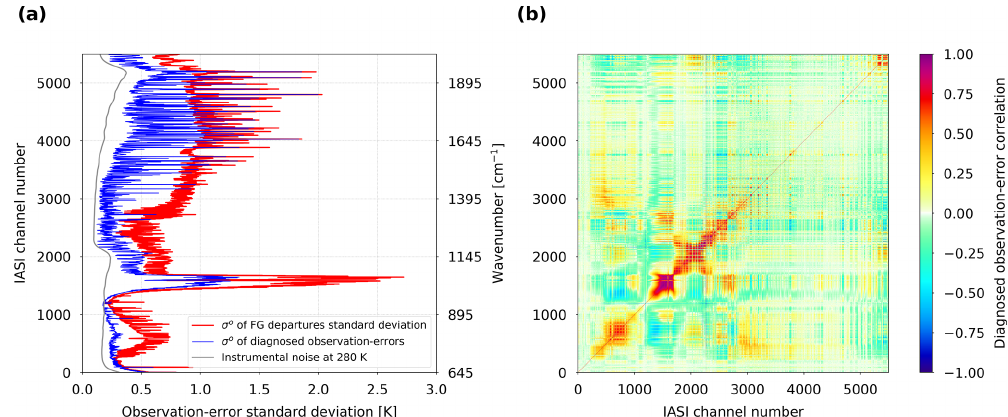
Figure 7. Observation-error standard deviation from FG departures standard deviation with a red line, diagnosed observation errors from Desroziers’ method using 1D-Var data assimilation system with a blue line and instrumental noise at 280K in grey with respect to 5499 IASI channel number and wavenumber (cm − 1 ) (bands 1 and 2 without channel 1194) over the set of 6123 atmospheric profiles (a) . Diagnostic IASI observation-error correlation with respect to the same channels as before (b) .